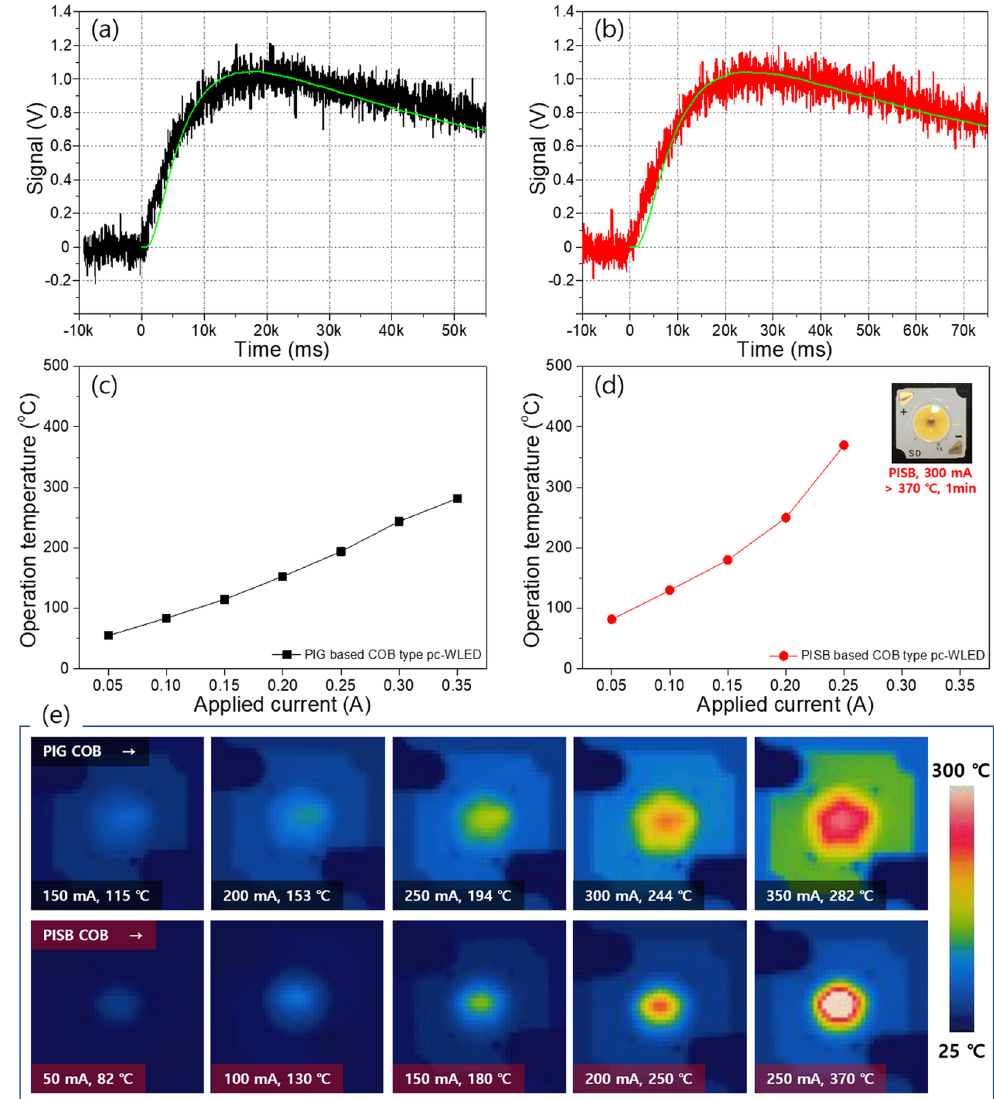
Figure 5. Thermal diffusivity surveys at 6500 K: ( a ) PIG plate and ( b ) PISB film with similar thicknesses of the phosphor-mixed encapsulant used on an on-chip COB LED. Operation temperatures of ( c ) the PIG-based and ( d ) the PISB-based on-chip COB WLEDs. The inset photograph shows a PISB-based COB WLED operated at 300 mA for 1 min. ( e ) Heat flux images of 6500 K PIG and the PISB-based on-chip COB WLEDs with variation of the